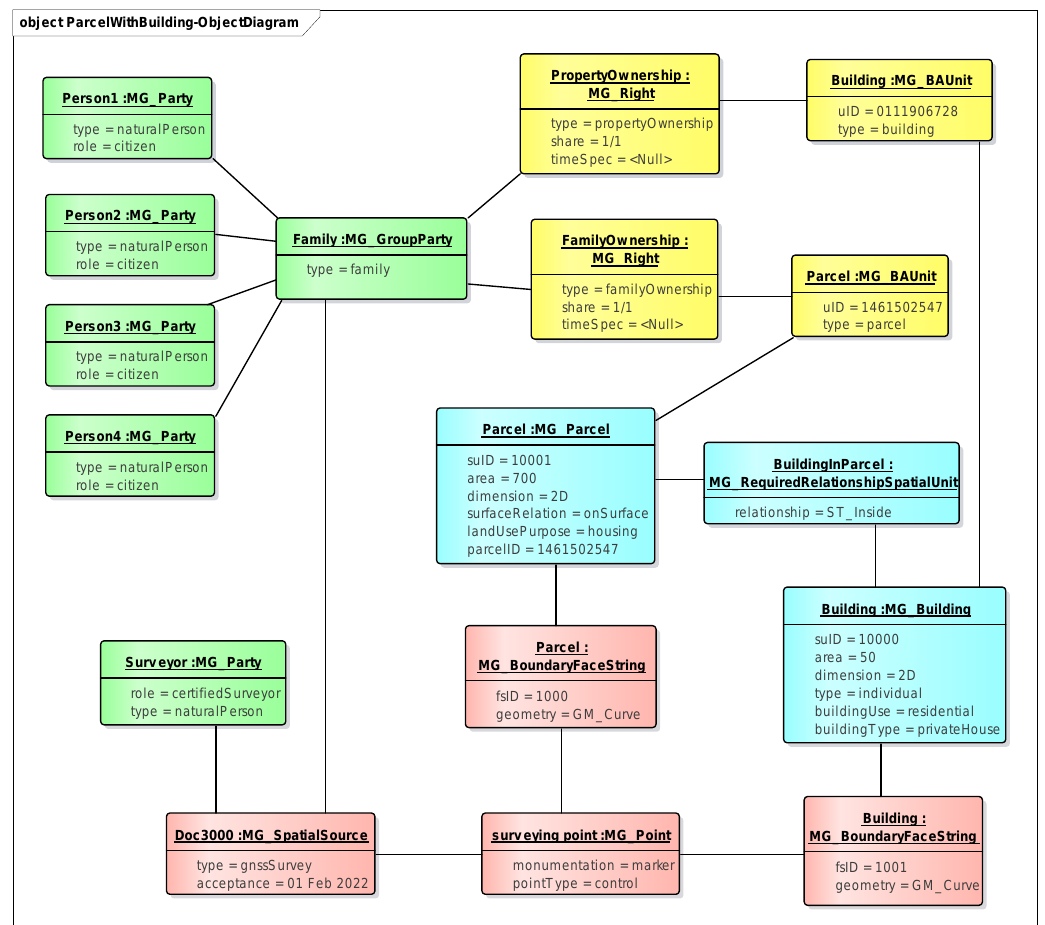
Figure 10. Instance Diagram of Party, Administrative, Spatial Unit (Parcel with Building), and Surveying and Representation Subpackage.